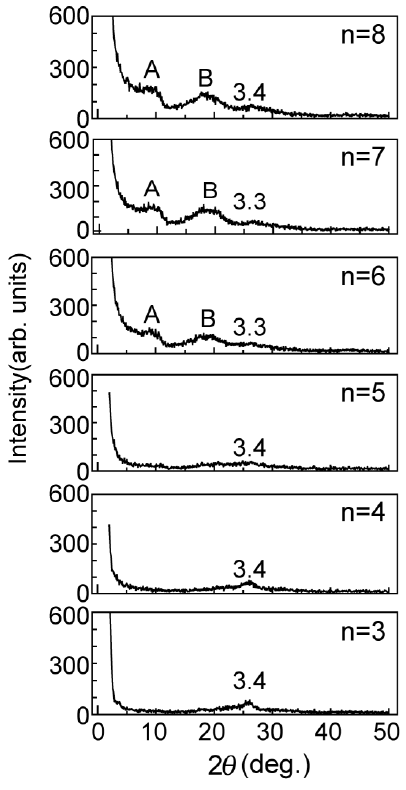
Figure 2. XRD intensity from the GO-C 80 minutes at 600 °C under a high vacuum of 10 −6 Torr.